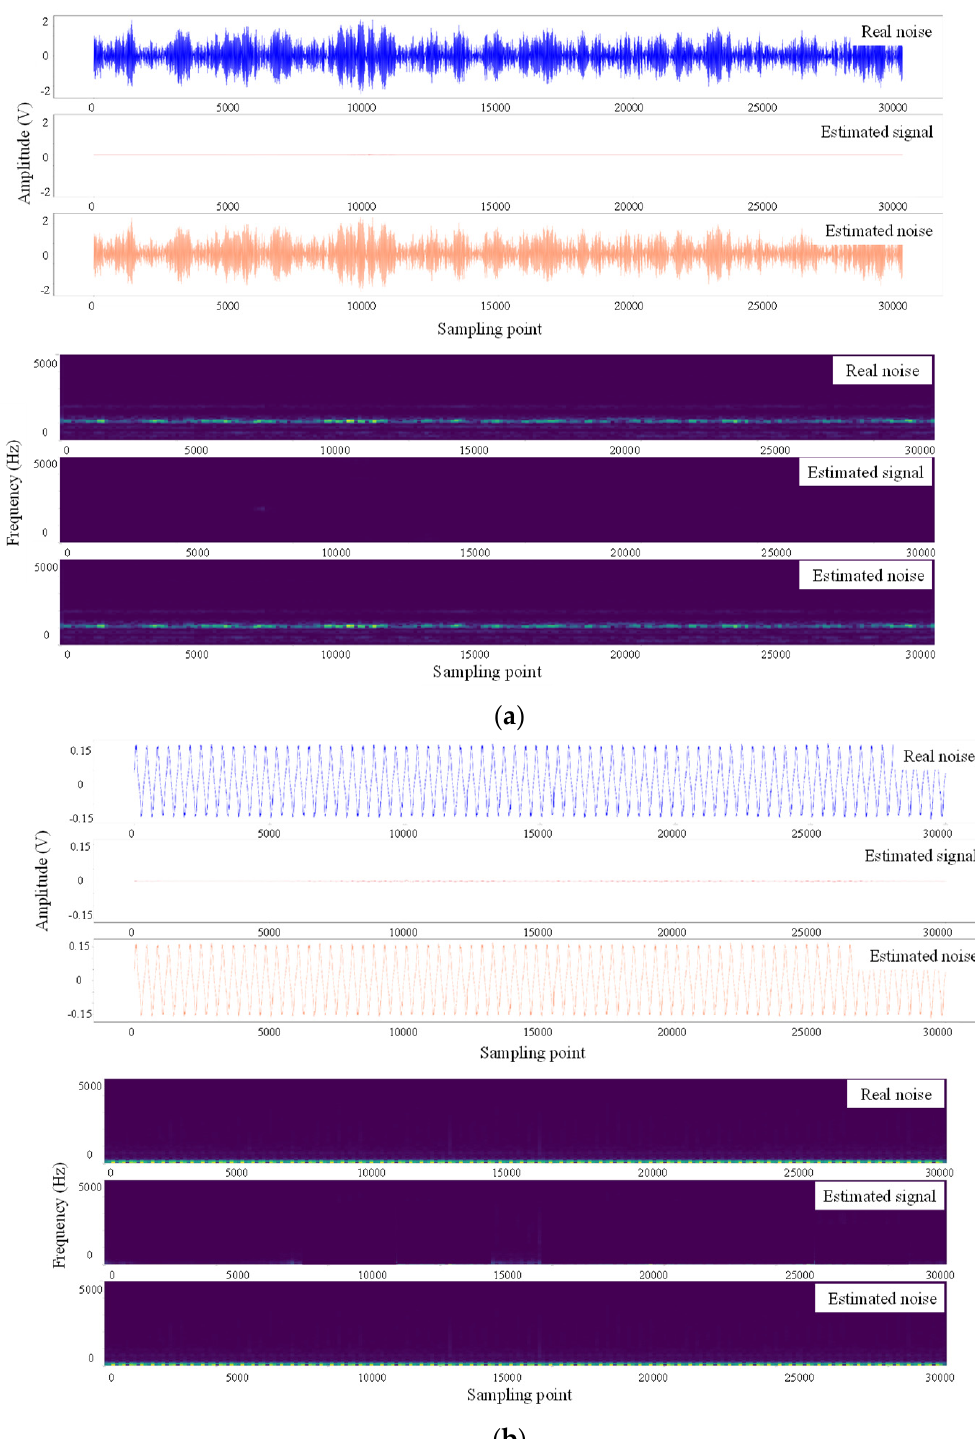
Figure 4. Denoising performance of CNN-denoiser for different types of real noise. The noises in the time domain and time–frequency domain are real noise, estimated signal and estimated noise from top to bottom of each sub-figure. ( a ) Mixture of cyclic noise and other noise; ( b ) cyclic noise.